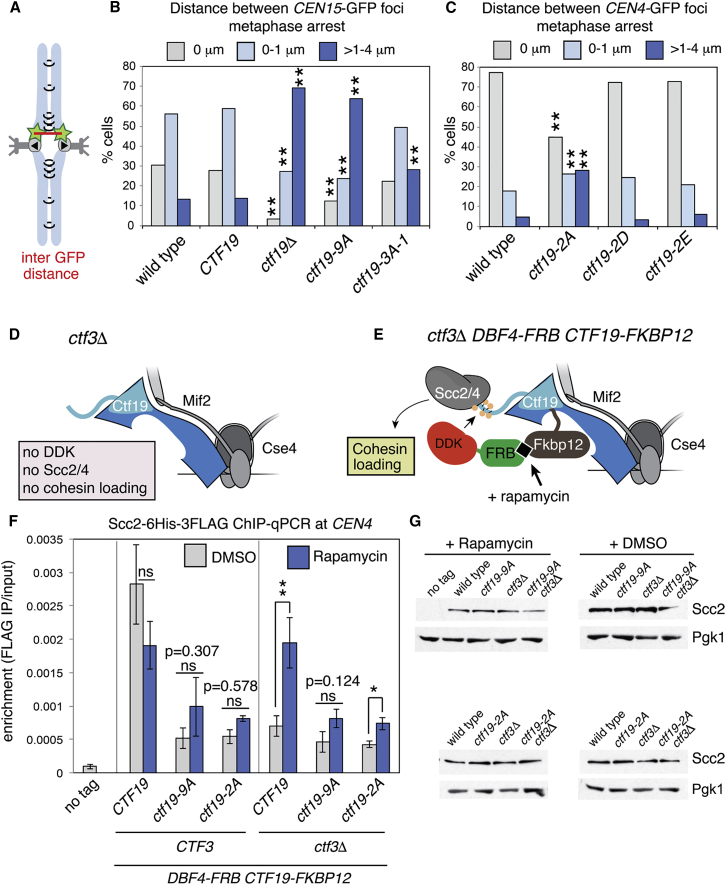
Ctf19 Phosphorylation Is Required for Centromeric Cohesion Establishment(A) Schematic depicting sister centromere separation at metaphase. Distance between centromere-associated GFP foci (green stars) was measured (red line).(B and C) Sister centromeres are further apart in metaphase in ctf19-9A cells compared to wild-type cells. (B) Strains bearing a lacO array at CEN15 (1.8 kb to the left of CEN15) and expressing LacI-GFP were imaged after arrest in metaphase by depletion of Cdc20 (pMET-HA3-CDC20) for 2h. Average centromere separation was determined for wild-type (SMH159), CTF19 (SMH412), ctf19Δ (SMH395), ctf19-9A (SMH396), and ctf19-3A-1 (SMH397) strains. Values were binned into categories (0 μm for no separation, 0–1 μm, and >1 μm–4 μm) and expressed as a percentage of all cells scored across three experiments. The fraction of cells in each bin was compared to the wild-type using Fishers exact test (∗∗p < 0.0001). (C) Phospho-null but not phospho-mimetic mutations in phosphorylation sites closest to the Ctf19 N terminus cause a centromere cohesion defect. Wild-type (AM4643), ctf19-2A (AM22083), ctf19-2D (AM22481), and ctf19-2E (AM22484) strains, all carrying +2.4 CEN4-GFP (2.4 kb to the right of CEN4) were arrested in G1 before release into medium containing methionine to deplete CDC20 for 2 hr before imaging and analyzed as in (B).(D and E) Schematic showing the cohesin loading defect in ctf3Δ cells (D) and rescue of this defect by artificial tethering of Dbf4-FRB to the kinetochore (E).(F) Scc2 localization was assessed by ChIP-qPCR in the presence or absence of DDK tethering, CTF3, and Ctf19 phosphorylation sites. Wild-type (AM21613), ctf19-9A (AM21681), ctf19-2A (AM22360), ctf3Δ (AM21614), ctf19-9A ctf3Δ (AM21617), ctf19-2A ctf3Δ (AM22672), and control (AM21486) strains, all expressing DBF4-FRB and CTF19-FKBP12, were arrested in G1 for 3 hr before release into medium containing nocodazole, benomyl, and either DMSO (no DDK tethering) or rapamycin (DDK tethering; 1 μM) for 2.5 hr. Mean values of at least four independent experiments are shown. Error bars indicate SE (∗p < 0.05; ∗∗p < 0.01; Student’s t test, unpaired, two-tails; ns, not significant).(G) Immunoblots showing relative levels of Scc2-6His-3FLAG and Pgk1 (loading control) in a representative experiment.